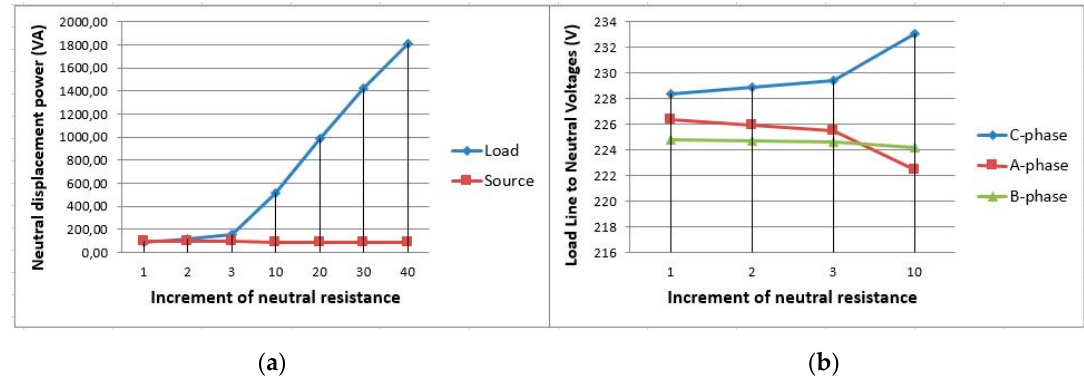
Figure 5. ( a ) Load and source neutral-displacement powers; ( b ) load phase voltages.